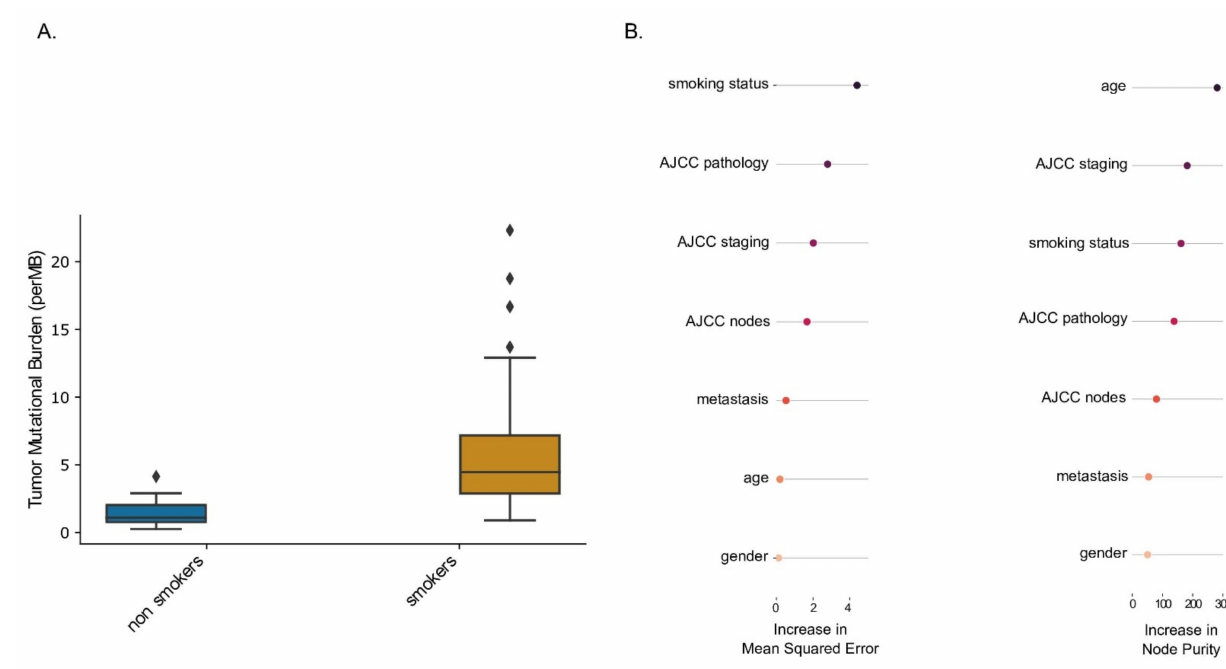
Figure 5. Tumor mutational burden increases in smokers affected with lung adenocarci- noma. ( A ) Analysis of the TCGA molecular dataset on lung adenocarcinoma patients was performed comparing molecular signatures in lifelong non-smokers versus tobacco smokers. A higher TMB was observed in smokers compared to non-smokers (medianTMB smokers = 4.5, medianTMB non-smokers = 1.09; p -value = 4.13 × 10 − 10 Wilcoxon Rank Sum test with continuity